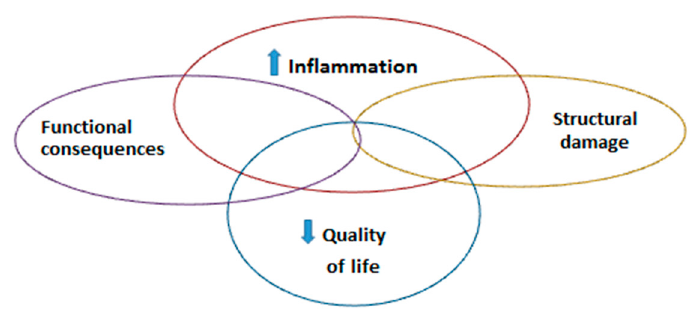
Figure 2. Consequences of flares.